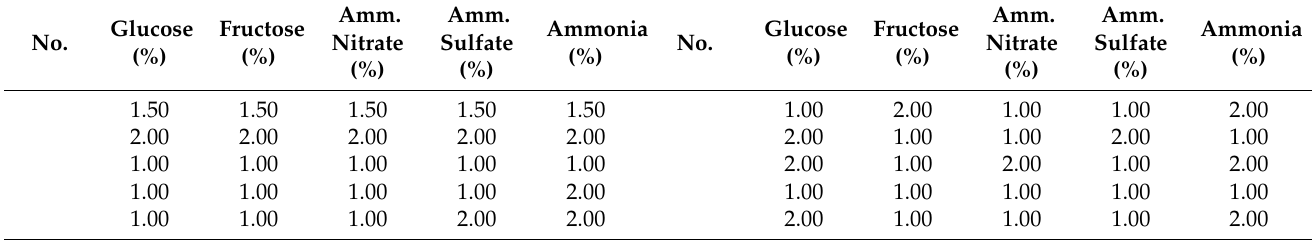
Table 2. Experimental design for the optimization of nutritional parameters during the biodegrada- tion of effluents (Conc. are in % age by